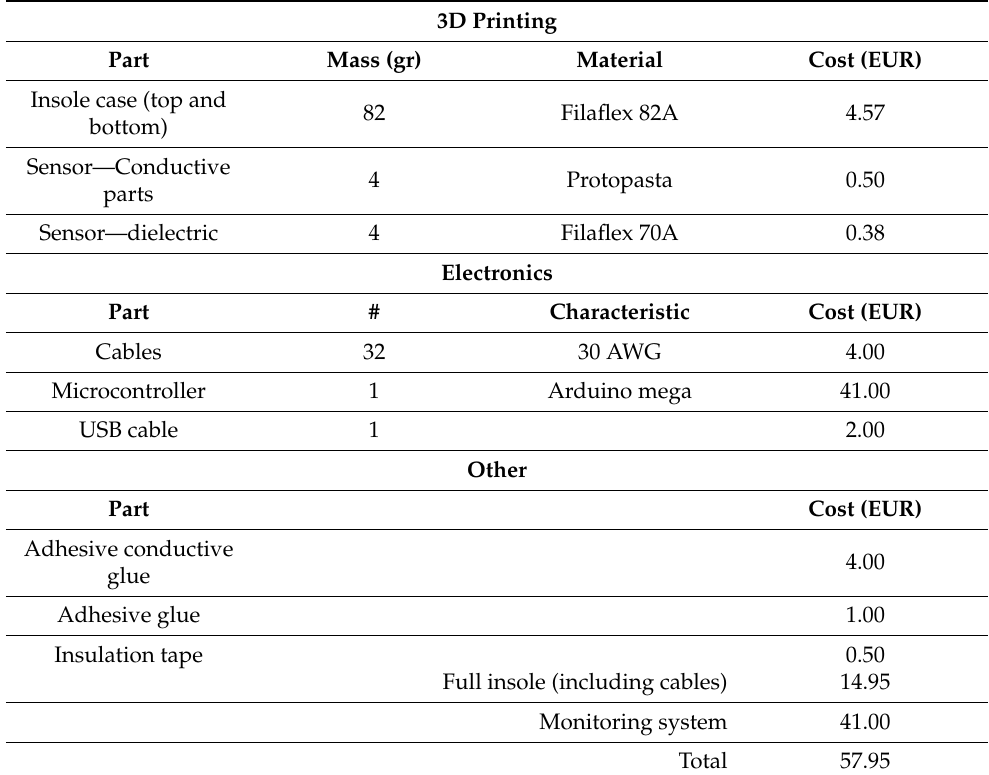
Table 2. Analysis of the cost per